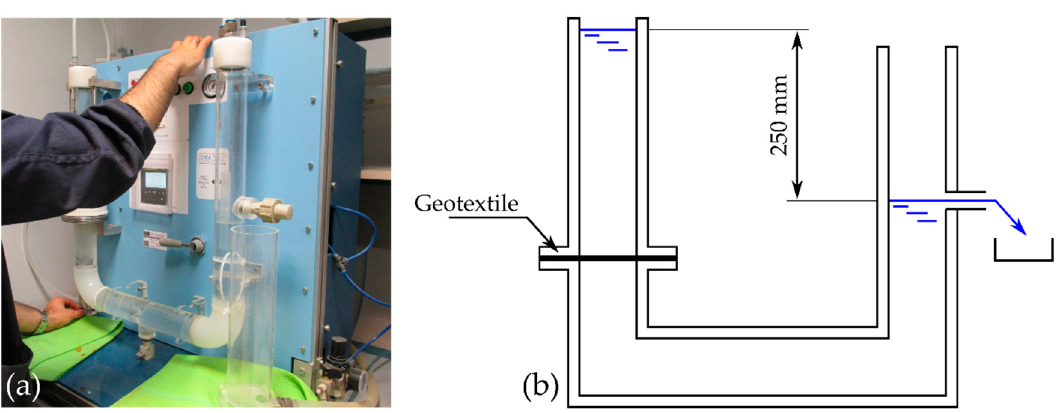
Figure 4. Equipment used to perform water permeability normal to the plate test. ( a ) Photography of the equipment; and ( b ) schematic drawing of the test arrangement (modified from [16]).